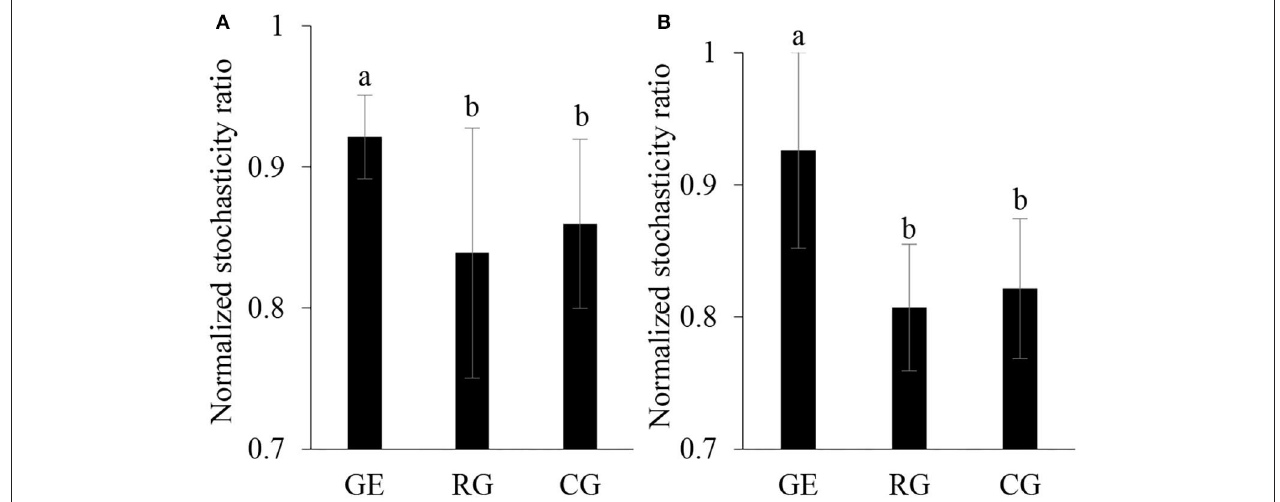
FIGURE 3 | Normalized stochasticity ratio of community assembly of soil bacteria (A) and fungi (B) . GE, grazing exclusion; RG, rotational grazing; and CG, continuous grazing. Different lowercase letters indicate significant differences between grazing regimes ( p < 0.05).